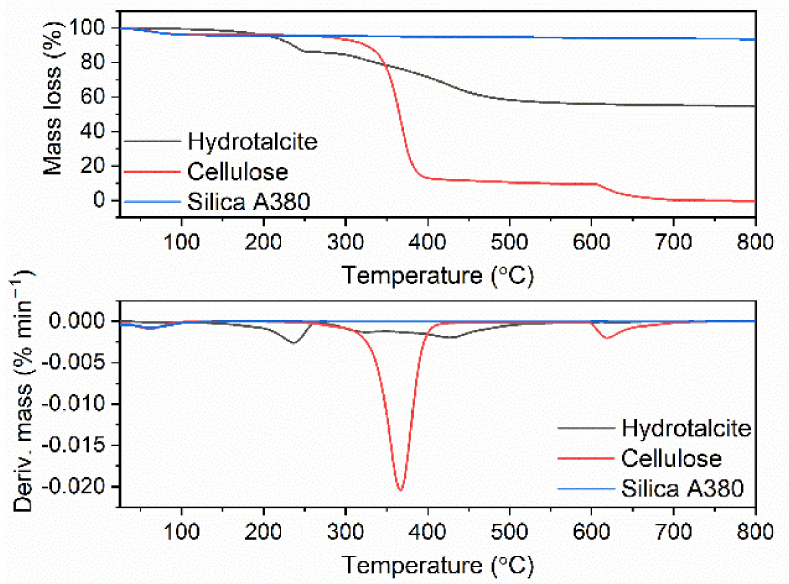
Figure 2. TG and DTG curves of pure